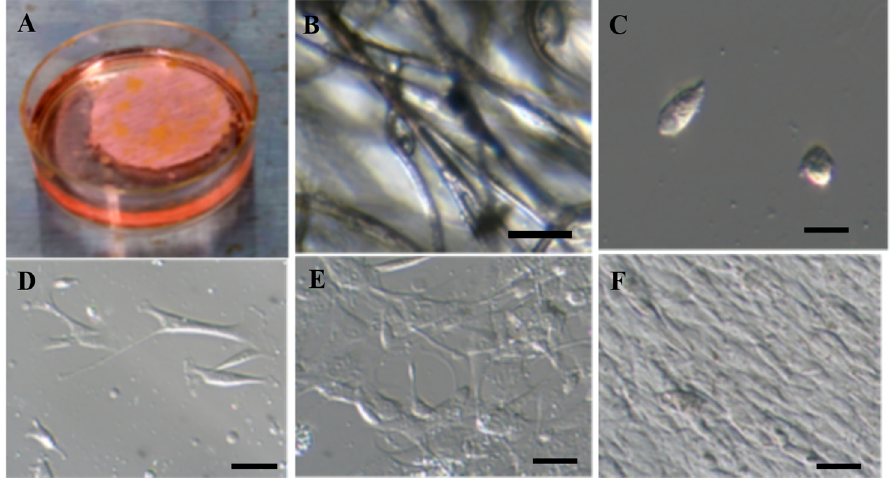
Figure 1. Isolation and culture of adipose-derived mesenchymal stem cells (ADMSCs). ( A ) Adipose- tissue fragments on a polyethylene polypropylene (PEPP) seat. ( B ) ADMSCs attach to fibers in the PEPP seat. Red arrows, ADMSCs. ( C ) Adipose-derived mesenchymal stem cells (ADMSCs) immediately after being isolated from a PEPP seat. ( D ) Three days after the isolation of ADMSCs. ( E ) Semi-confluent condition at 10 days after the isolation of ADMSCs. ( F ) Confluent condition at 14 days after the isolation of ADMSCs. Scale bar, 10 µ